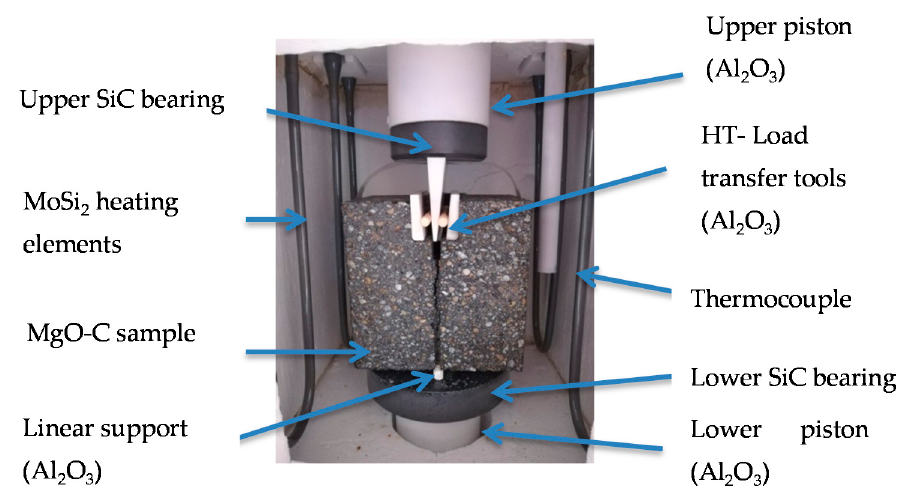
Figure 5. Wedge splitting test setup and sample after testing.